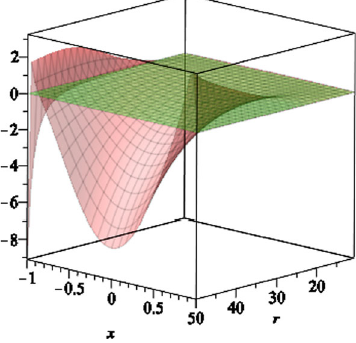
Fig. 4 The scaled function S ( r , x ) versus 0 ≤ r ≥ r H and − 1 ≤ x ≤ 1, where we set the black hole parameters a = 6 , b = 2 , l = 1 , m = 7 and q = 1. The stationary limit surface r s ( x ) is the intersection of the function S ( r , x ) with the horizontal plane at zero